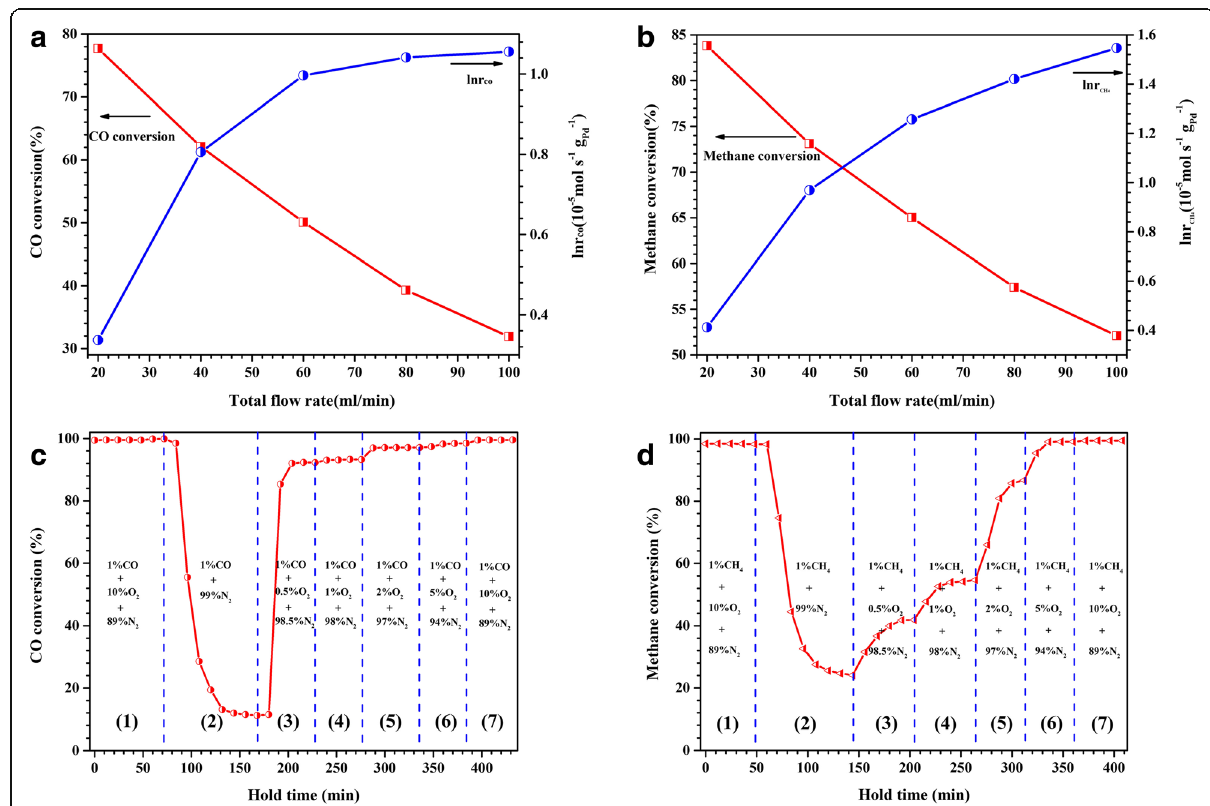
Fig. 10 Catalytic activity and reaction rate of the dealloyed Al 91.3 Ce 8 Pd 0.7 ribbons calcined at 400 °C for CO oxidation with different flow rates at 20 °C ( a ) and for methane combustion with different flow rates at 320 °C ( b ) (reaction gas 1 vol% CO/CH 4 , 10 vol% O 2 , and 89% vol% N 2 .). The catalytic activity of the dealloyed Al 91.3 Ce 8 Pd 0.7 ribbons calcined at 400 °C for CO oxidation in the presence of different O 2 concentrations at 80 °C ( c ) and for methane combustion in the presence of different O 2 concentrations at 380 °C ( d